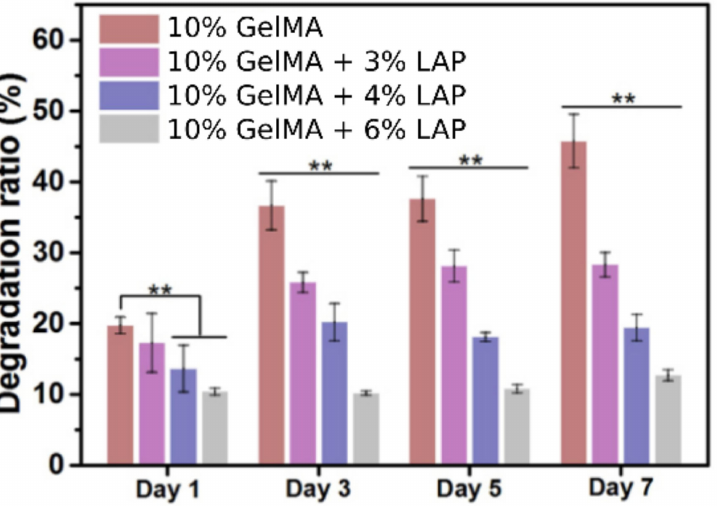
Figure 18. Degradation ratio of different GelMA/LAP bioinks for 7 days. Double asterisk (**) indicates significant differences between groups with p -value < 0.01 (ANOVA). Reproduced with permission from [96], IOP Publishing,